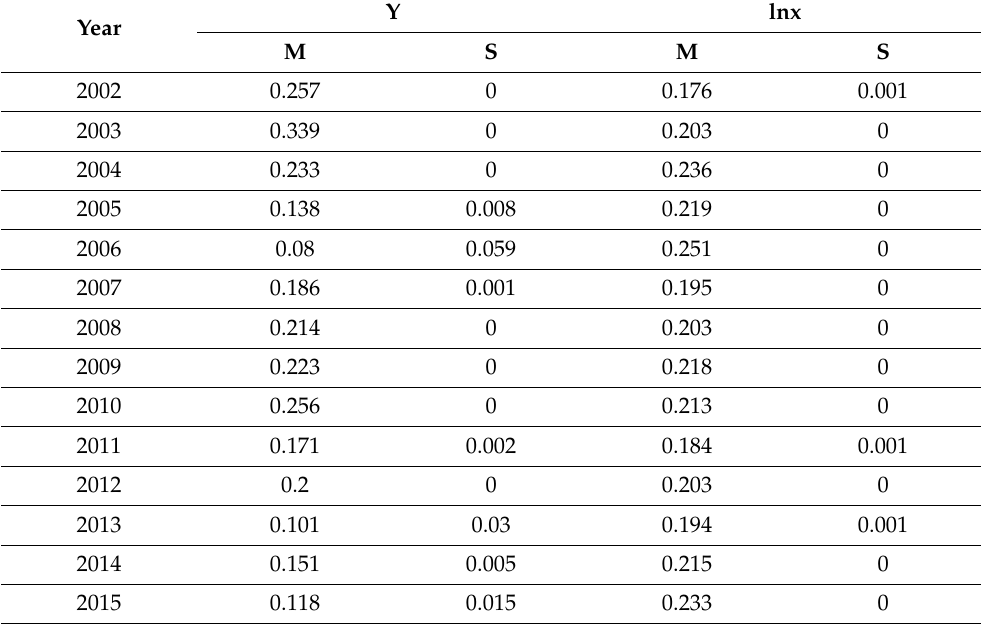
Table 3. Moran’s I test results of the proportion of the health expenditure in consumption expenditure of rural residents and the annual average concentration of